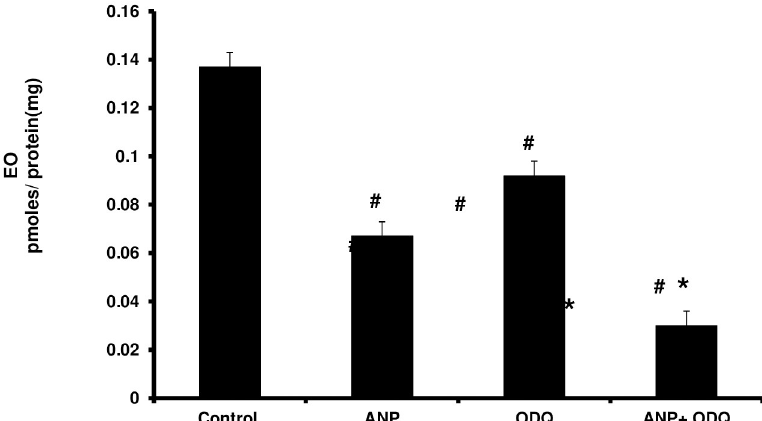
Fig 5. Effect of ANP on EO secretion. Change in EO secretion 60 min following addition of ANP 50 pg/mL, 10 mM ODQ and ODQ+ANP treatment. ANP alone and ODQ alone reduced EO secretion ( # P < 0.05 compared to control). Pretreatment with ODQ followed by ANP further decreased secreted EO when compared to ANP or ODQ alone ( � P < 0.05). (Error bars represent standard error; Y axis units are pM/mg protein).